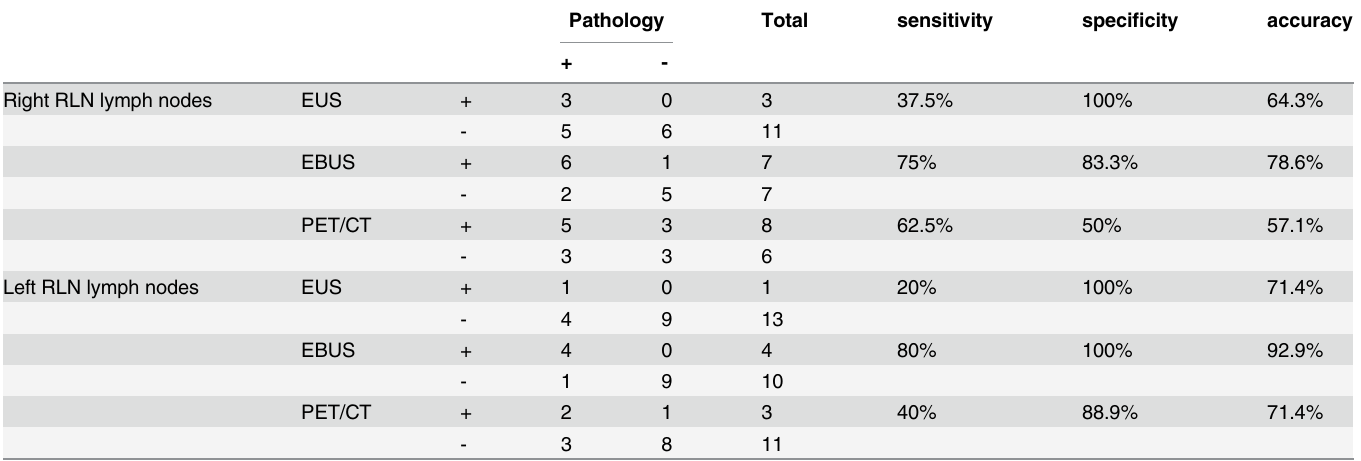
Table 5. Comparison of the accuracy of the diagnosis of right and left RLN lymph node metastasis by EBUS, EBUS and PET/CT, compared with the result from surgical pathology.